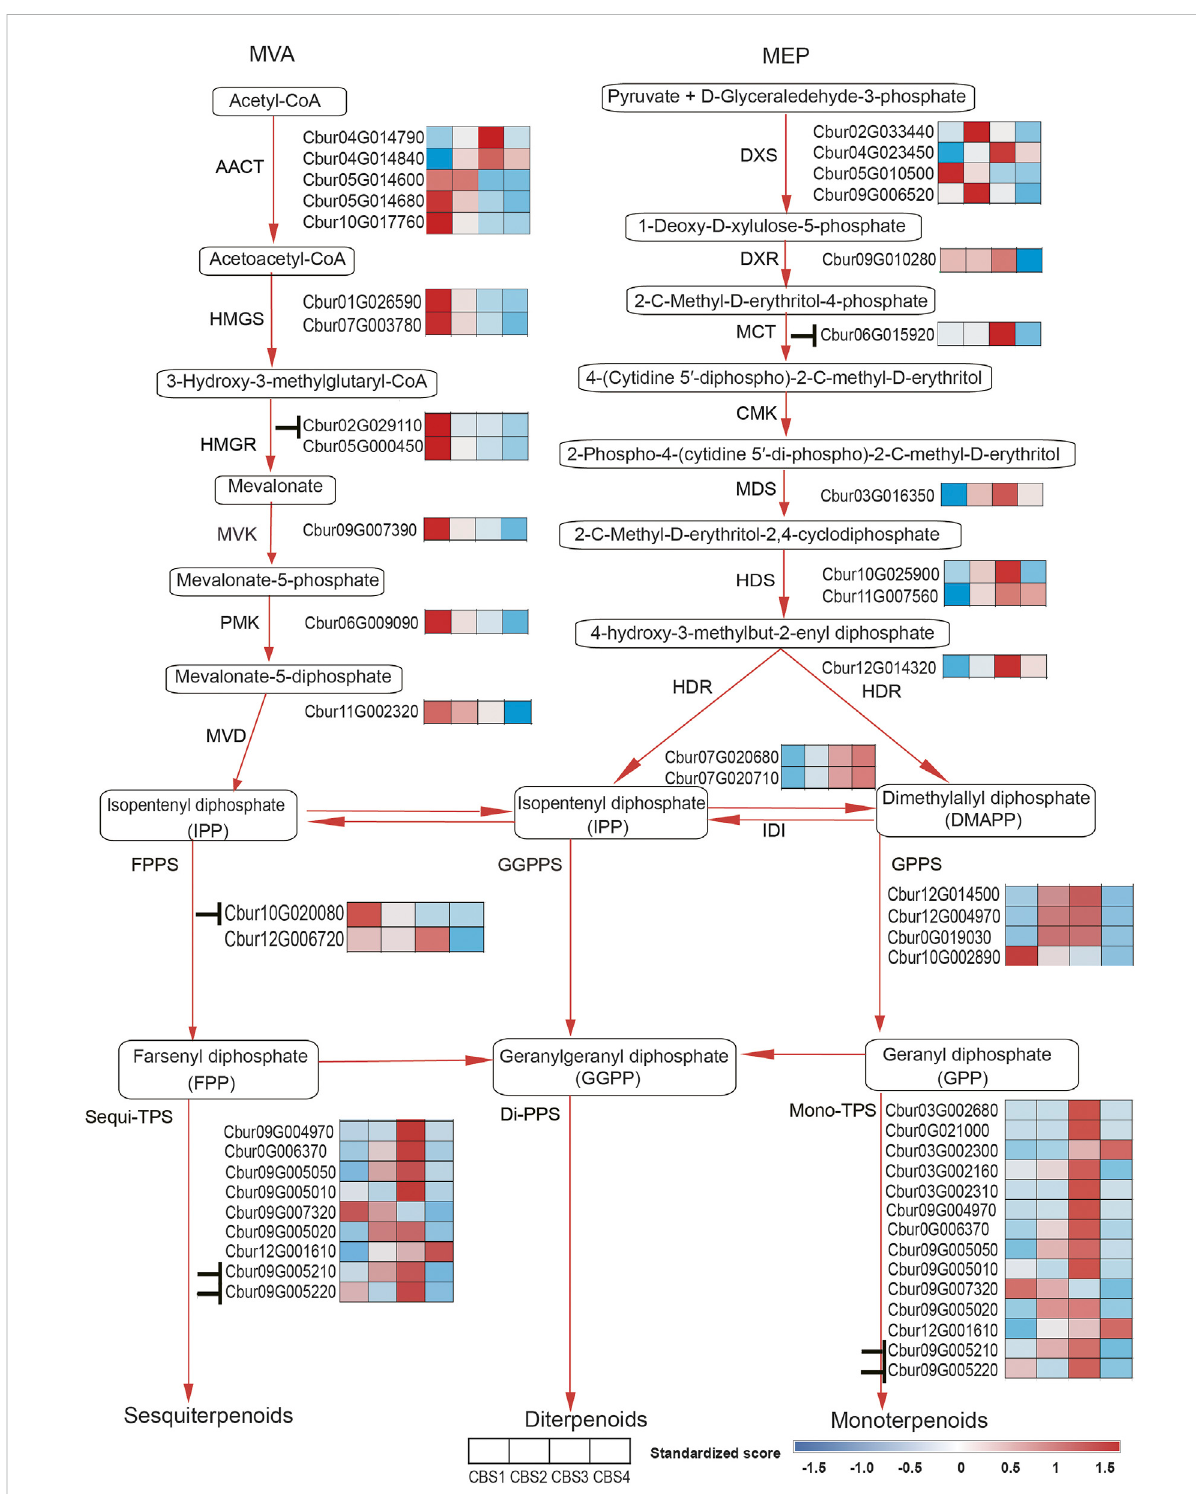
FIGURE 6 Differentiallyexpressedgenes(DEGs)ofMVAandMEPpathwaysin Cinnamomumburmannii .HeatmapsshowtheexpressionlevelsoftheDEGs involved in MVA and MEP pathways across four leaf developmental stages. Based on the target gene prediction using LncTar. The symbol “ ⊥ ” represents the regulation of gene expression by the lncRNAs detected in the present